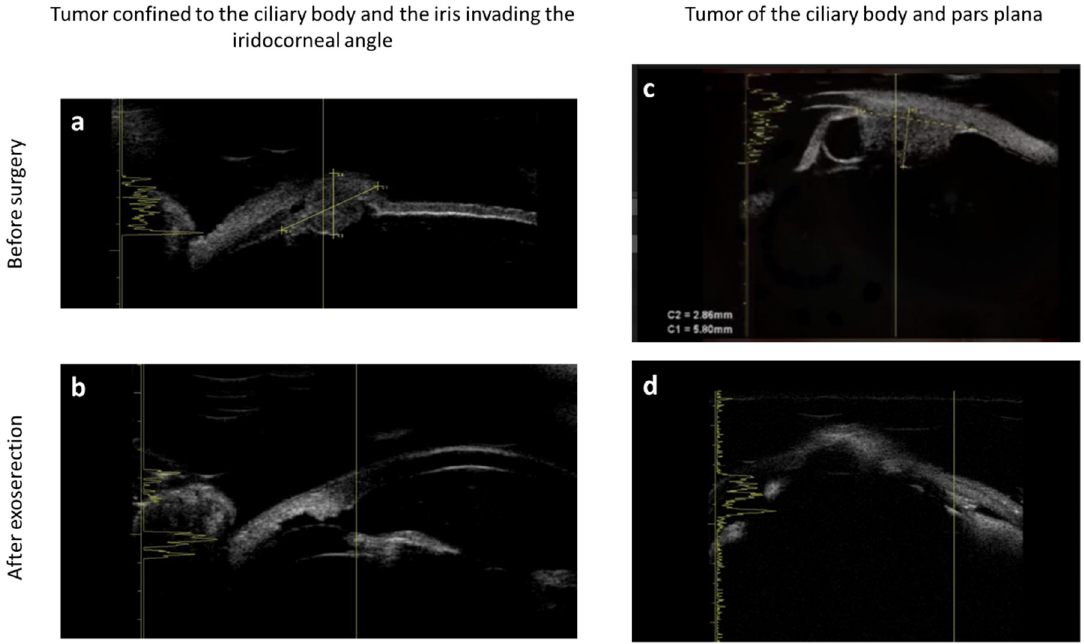
Figure 1. Ultrasound biomicroscopy of iris and ciliary body tumors. ( a , b ) Iris tumor invading angle; ( c , d ) ciliary body and pars plana tumors.